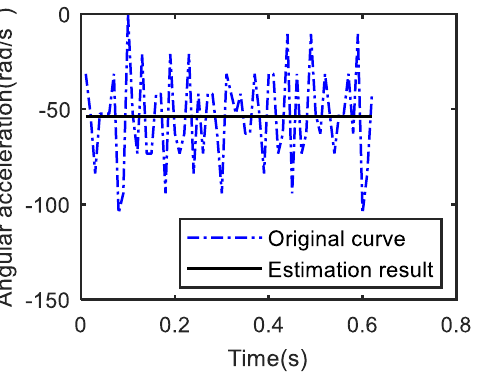
Figure 11. Comparison between AMT input shaft’s angular acceleration and estimation without TB